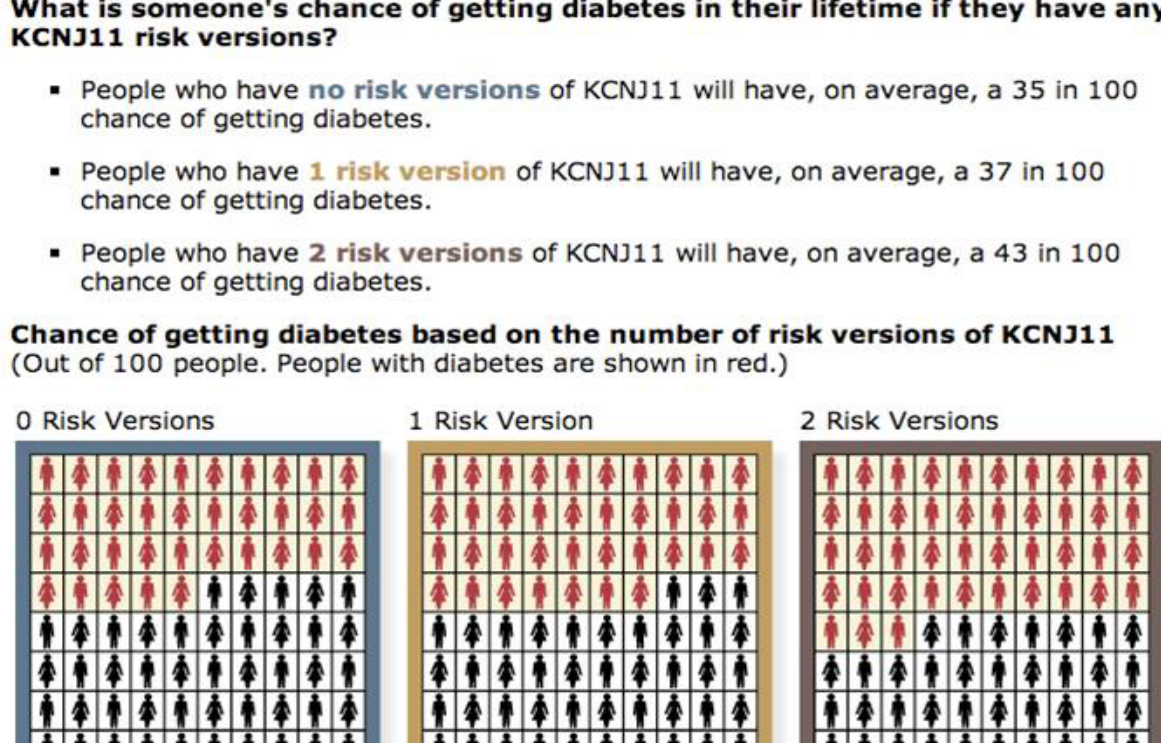
Figure 2. Example website page providing information about a gene on the